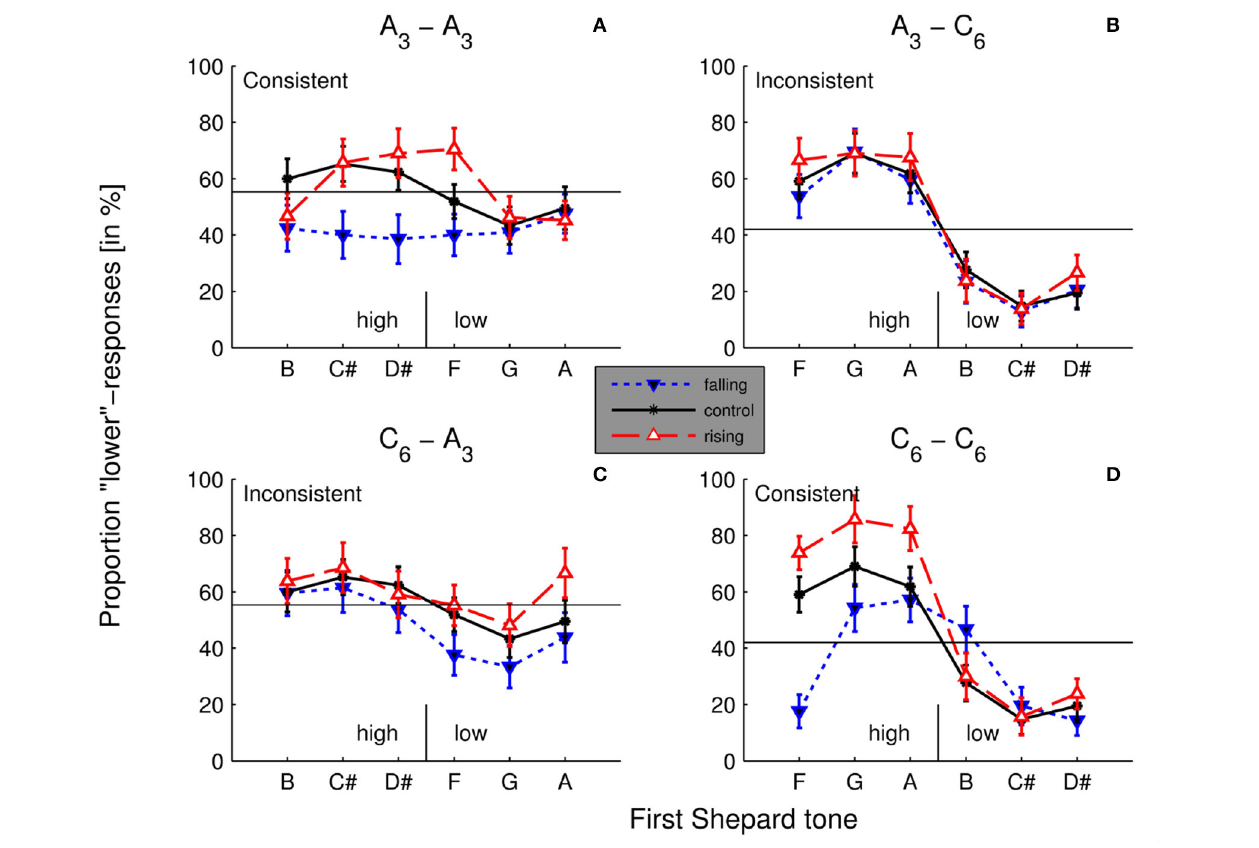
FIGURE 8 | Aftereffects in the different conditions. Averaged percentages of lower responses as function of the first Shepard tone in the control condition (without a preceding sequence) and the two experimental conditions (rising/falling preceding sequences) in all 4 adaptor - target combinations A 3 − A 3 (A) , A 3 − C 6 (B) , C 6 − A 3 (C) , C 6 − C 6 (D) . The horizontal line depicts the mean of lower responses in the control condition. Shepard tones that caused lower responses (forming a tritone pair) below the mean were labeled as high, those that caused lower responses over the mean as low (in the control condition). Identical envelopes of the tritone pairs and the adaptor lead to the consistent condition and different envelopes to the inconsistent condition ( n =